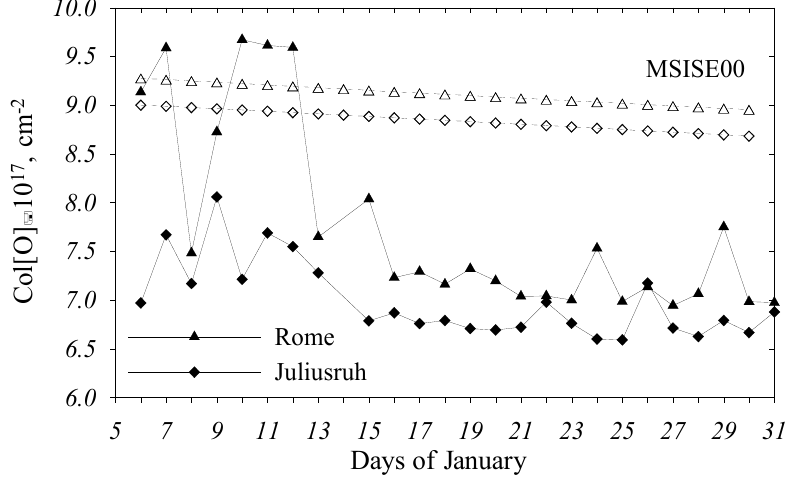
Figure 8. Retrieved column atomic oxygen abundance at Rome and Juliusruh in January 2009. Model MSISE00 variations are given with open symbols.